Question: From the figure, is the trend upward or downward?
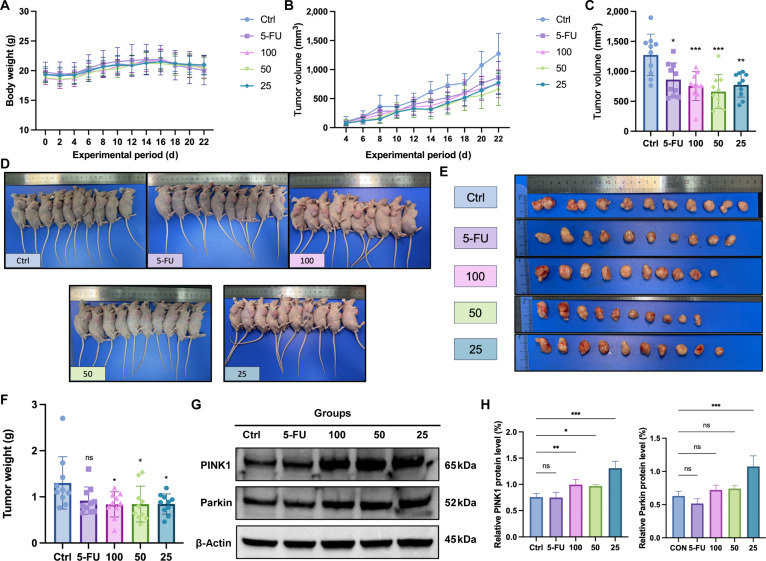
Answer: increasing